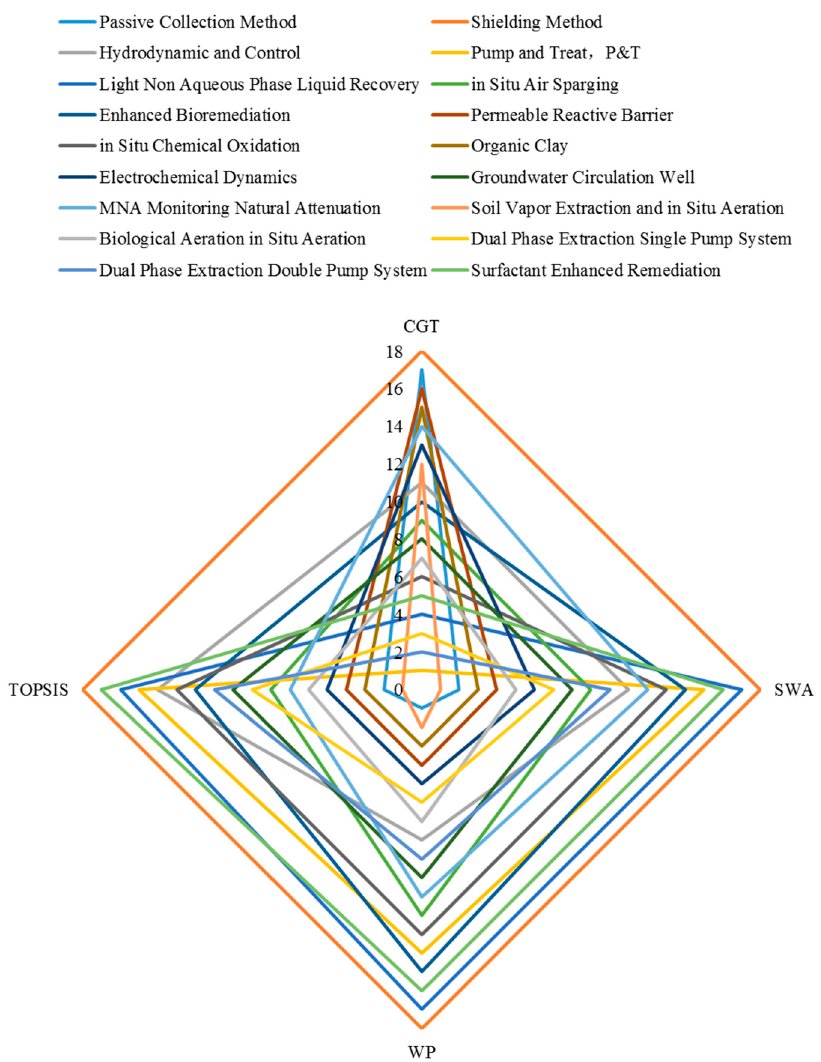
Figure 3. Ranking of four methods.